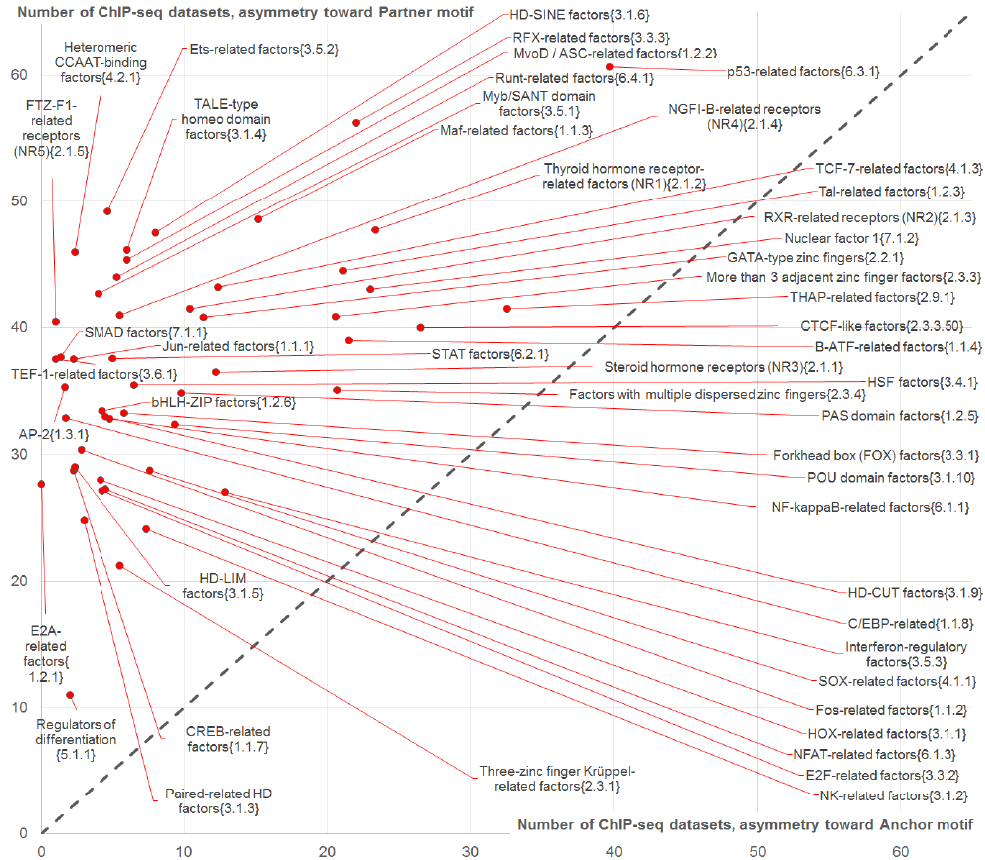
Figure 4. The scatterplot of abundances of asymmetric CEs toward the anchor (axis X) and asymmetric CEs toward the partner (axis Y) motifs for 50 clades of TFs. These clades comprised of 49 families of TFs with at least two motifs and subfamily CTCF-like factors {2.3.3.50} with two motifs from the Hocomoco human core collection [14]. Total number of ChIP-seq datasets was equal to 119 (Table S1). Only CEs with an overlap of motifs were considered. The diagonal dashed line marks equal numbers of datasets, it implies the partitioning of all clades into those with the higher abundance of asymmetric CEs toward partner motifs (top left triangle, all 50 clades) and those with the higher abundance of asymmetric CEs toward anchor motifs (bottom right triangle without clades).